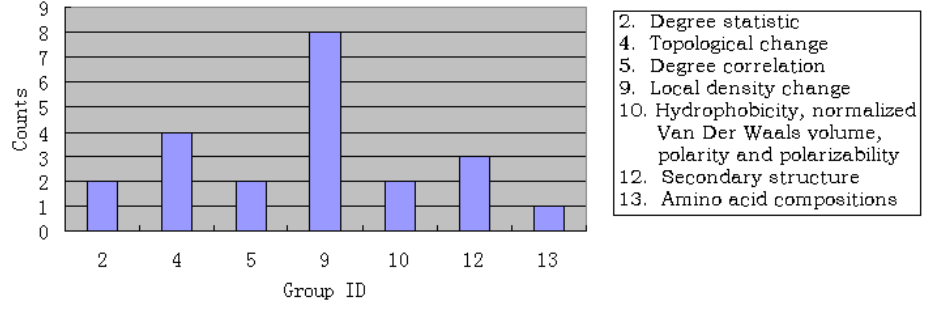
Figure 3. Distribution of the optimized 22 features. See the text in Section 3.2 for further